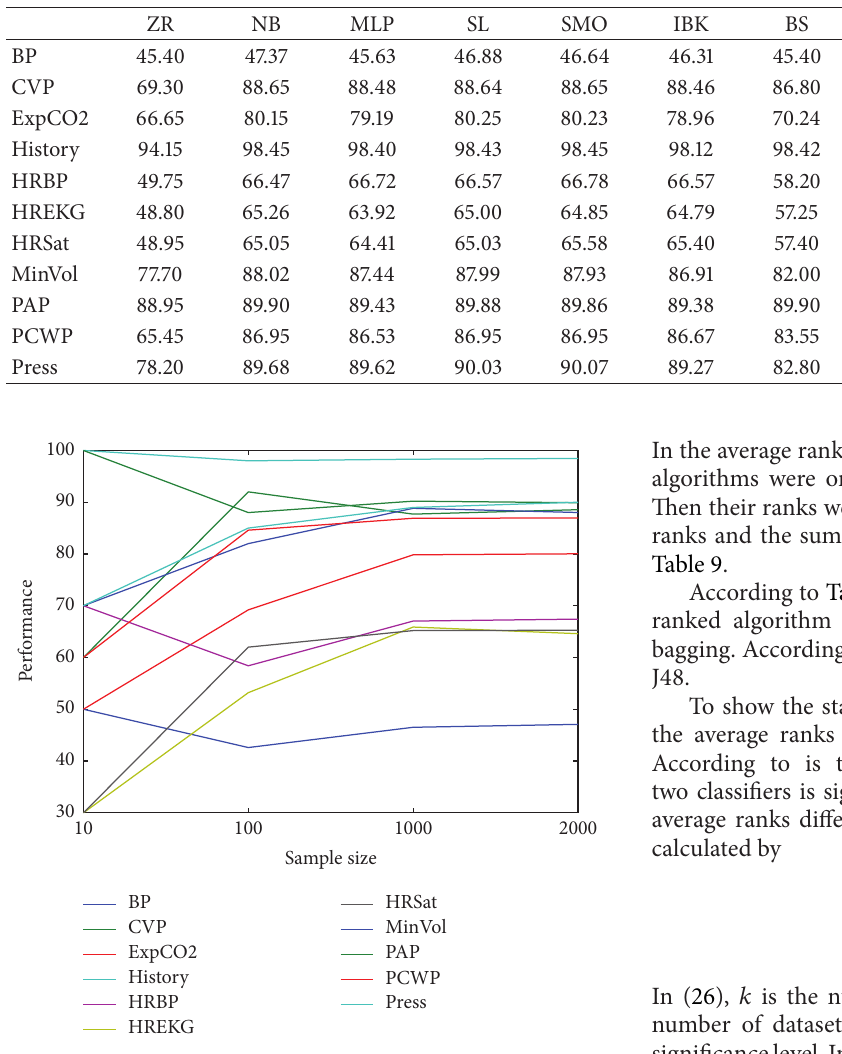
Figure 6: Classification accuracies changes with datasets’ sample